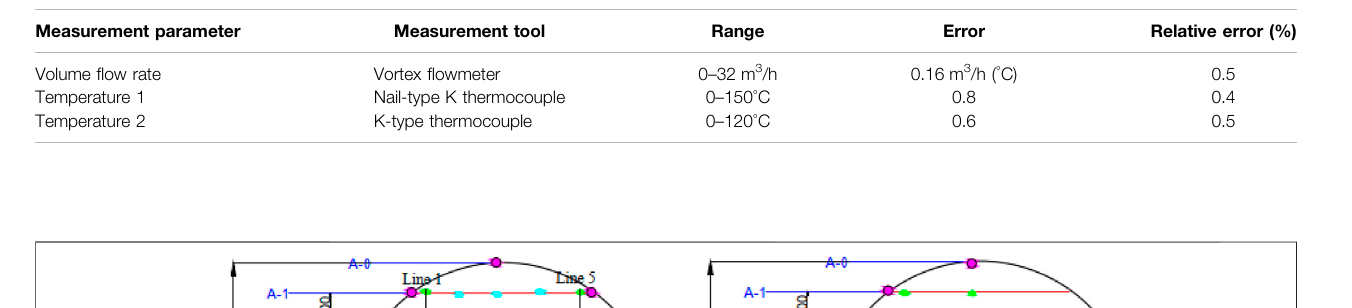
TABLE 1 | Measurement error and uncertainty.